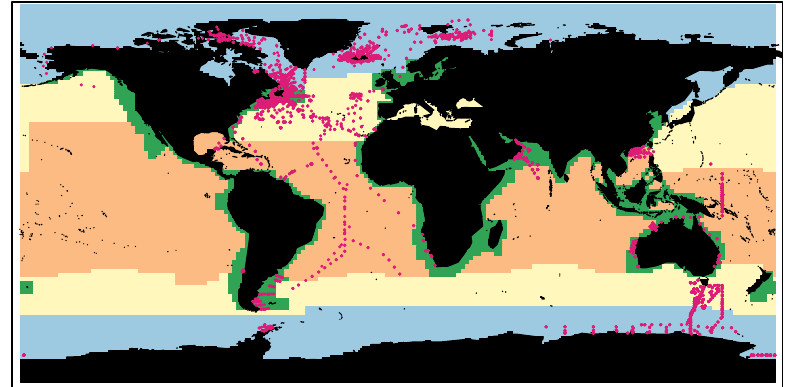
Figure 4. Global distribution of MAPPS P - E data set that passed quality control (5711 samples). The blocked colours represent the four primary biomes as described in Longhurst (2007): Polar (blue), Westerlies (yellow), Trades (orange) and Coastal (green).